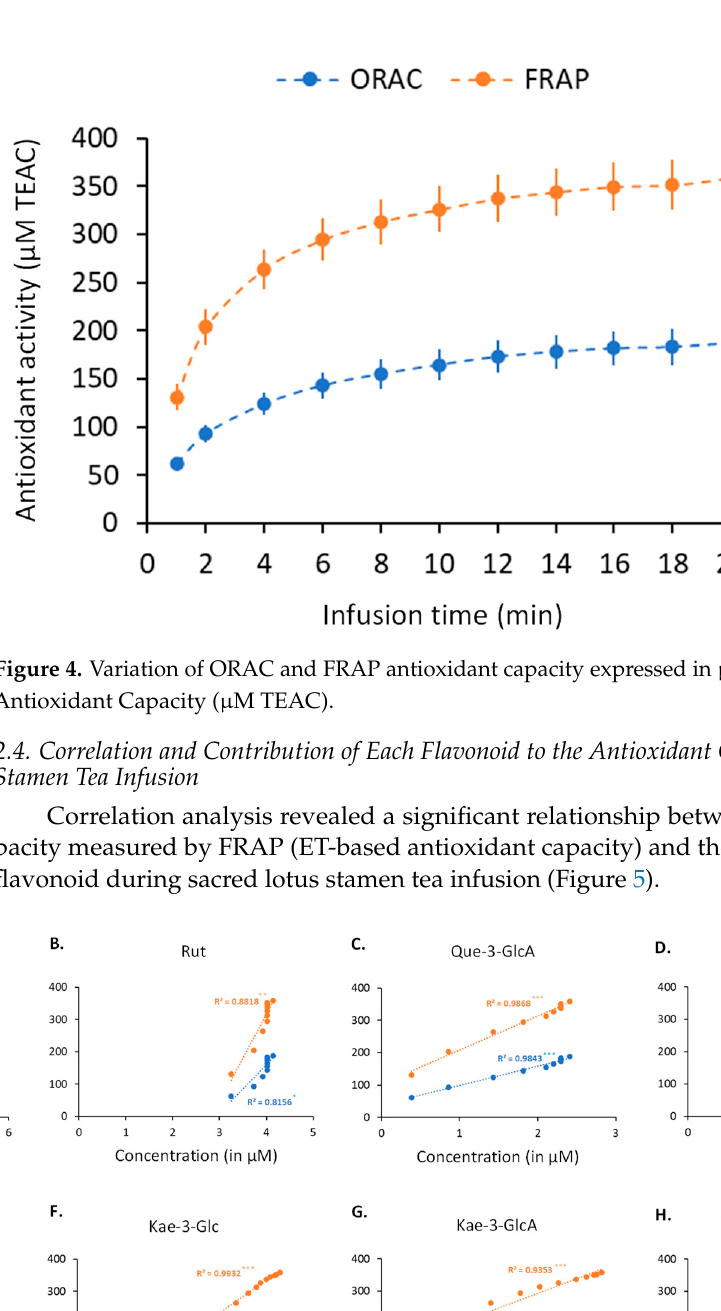
Figure 5. Correlation of antioxidant activity (ORAC (blue line) and FRAP (orange line) assays) with the concentration of Myr-3-Glc ( A ), Rut ( B ), Que-3-GlcA ( C ), Iso-3-Glc ( D ), Kae-3-Rob ( E ), Kae-3- Glc ( F ), Kae-3-GlcA ( G ) and total flavonoids ( H ). Myr-3-O-Glc: myricetin-3-O-glucose; Quer-3-O- Rut: quercetin-3-O-rutinoside (rutin); Quer-3-O-GlcA: quercetin-3-O-glucuronic acid; Kae-3-O-Rob: kaempferol-3-O-robinobiose; Kae-3-O-Glc: kaempferol-3-O-glucose; Kae 3-O-GlcA: kaempferol 3- O-glucuronic acid; Iso-3-O-Glc: isorhamnetin-3-O-glucose; Glc: glucose; GlcA: glucuronic acid; Rob: robinobiose. The highest correlation was found with the FRAP assay when compared to the ORAC assay, confirming the main ET-based antioxidant mechanism. Total flavonoids (R 2 = 0.9985, p < 0.001) and Kae-3-Glc (R 2 = 0.9932, p < 0.001) presented the highest correlation